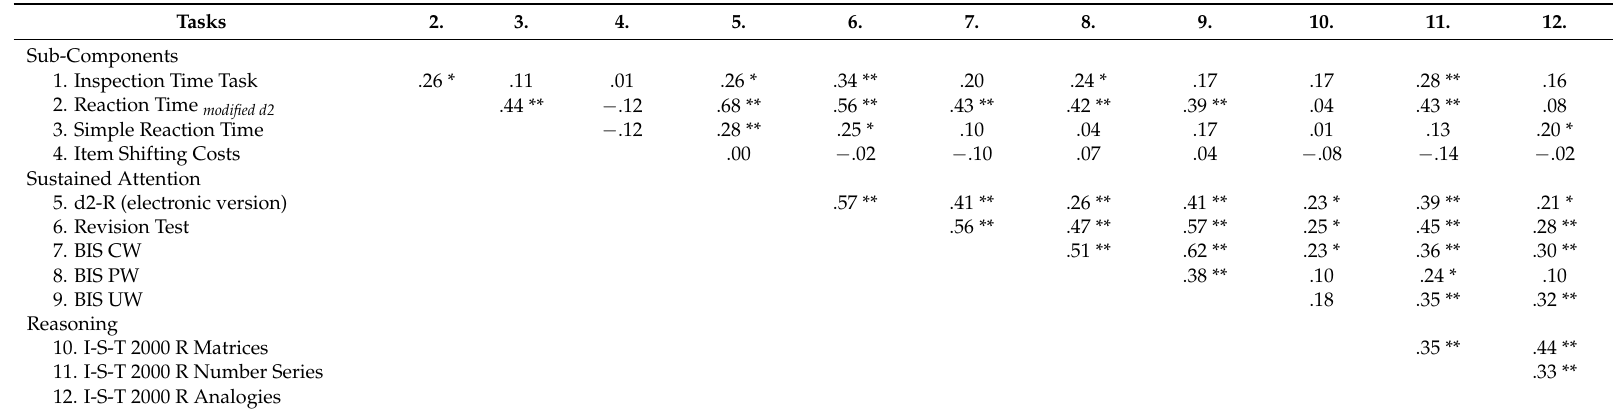
Table A2. Correlation matrix of the measures in Study